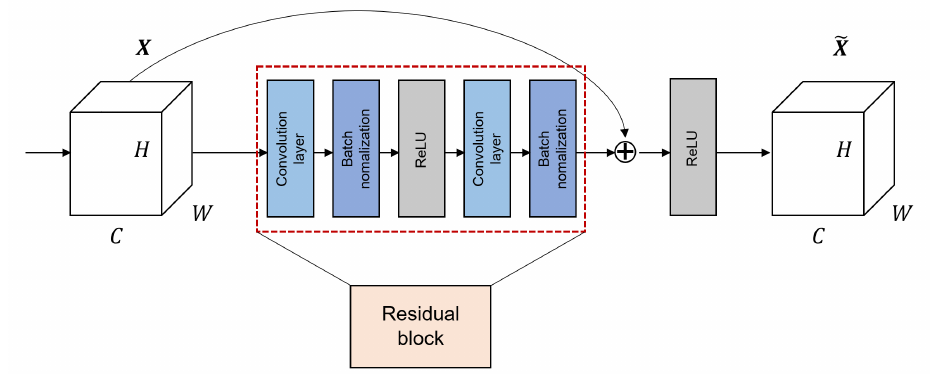
Figure 1. The structure of residual block in ResNet when the block is composed of two convolu- tion layers. Table 2. Architectural configurations for ResNet. Building blocks are shown in brackets, with the numbers of blocks